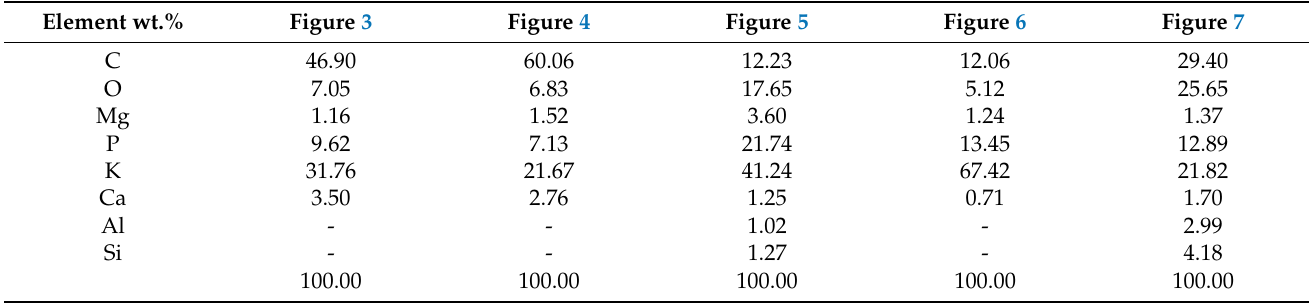
Figure 7. Surface area analysis from corn biochar (Elements from left to right K, Ca, C, O, Mg, Al, Si, P, K, Ca).